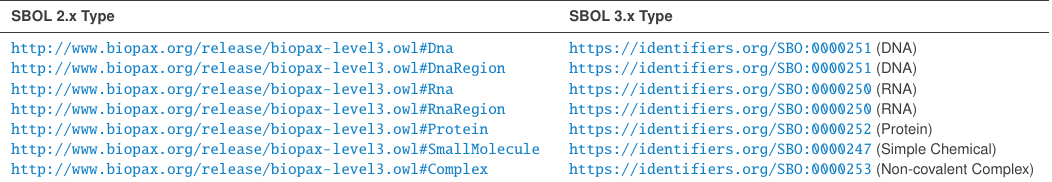
Section 10 Mapping Between SBOL 1, SBOL 2, and